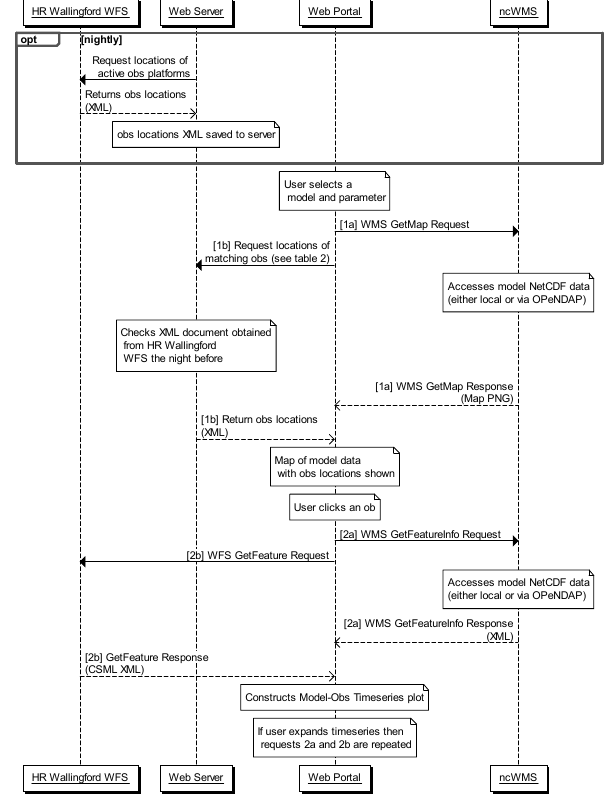
Fig. 3. Sequence diagram showing the calls made from the Godiva2 web portal (running in the browser client) to request the model and obs data, as well as the responses returned.